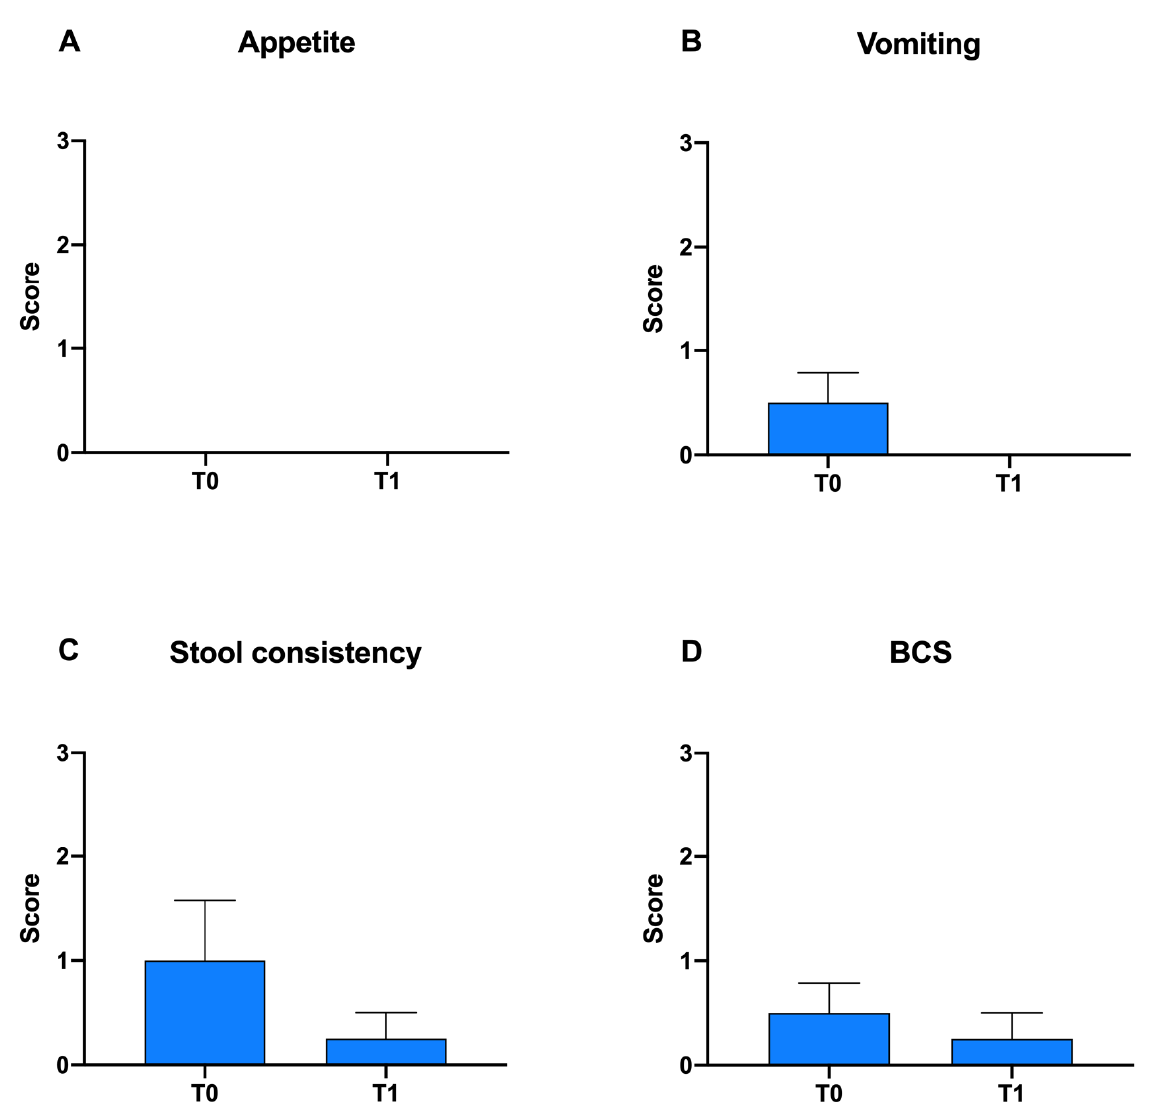
Figure 1. Graphical representation of the gastrointestinal parameters appetite ( A ), vomiting ( B ), stool consistency ( C ) and BCS ( D ), which make up the simplified FCEAI score within Group A at T0 vs. T1 following probiotic administration.